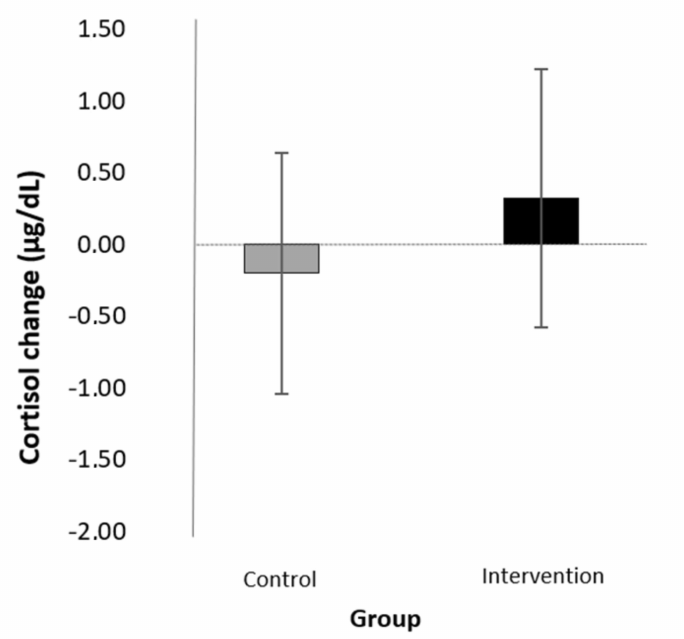
Figure 4. Effects of the intervention (mean of the change scores and SD) on morning cortisol levels from pre-test to September in